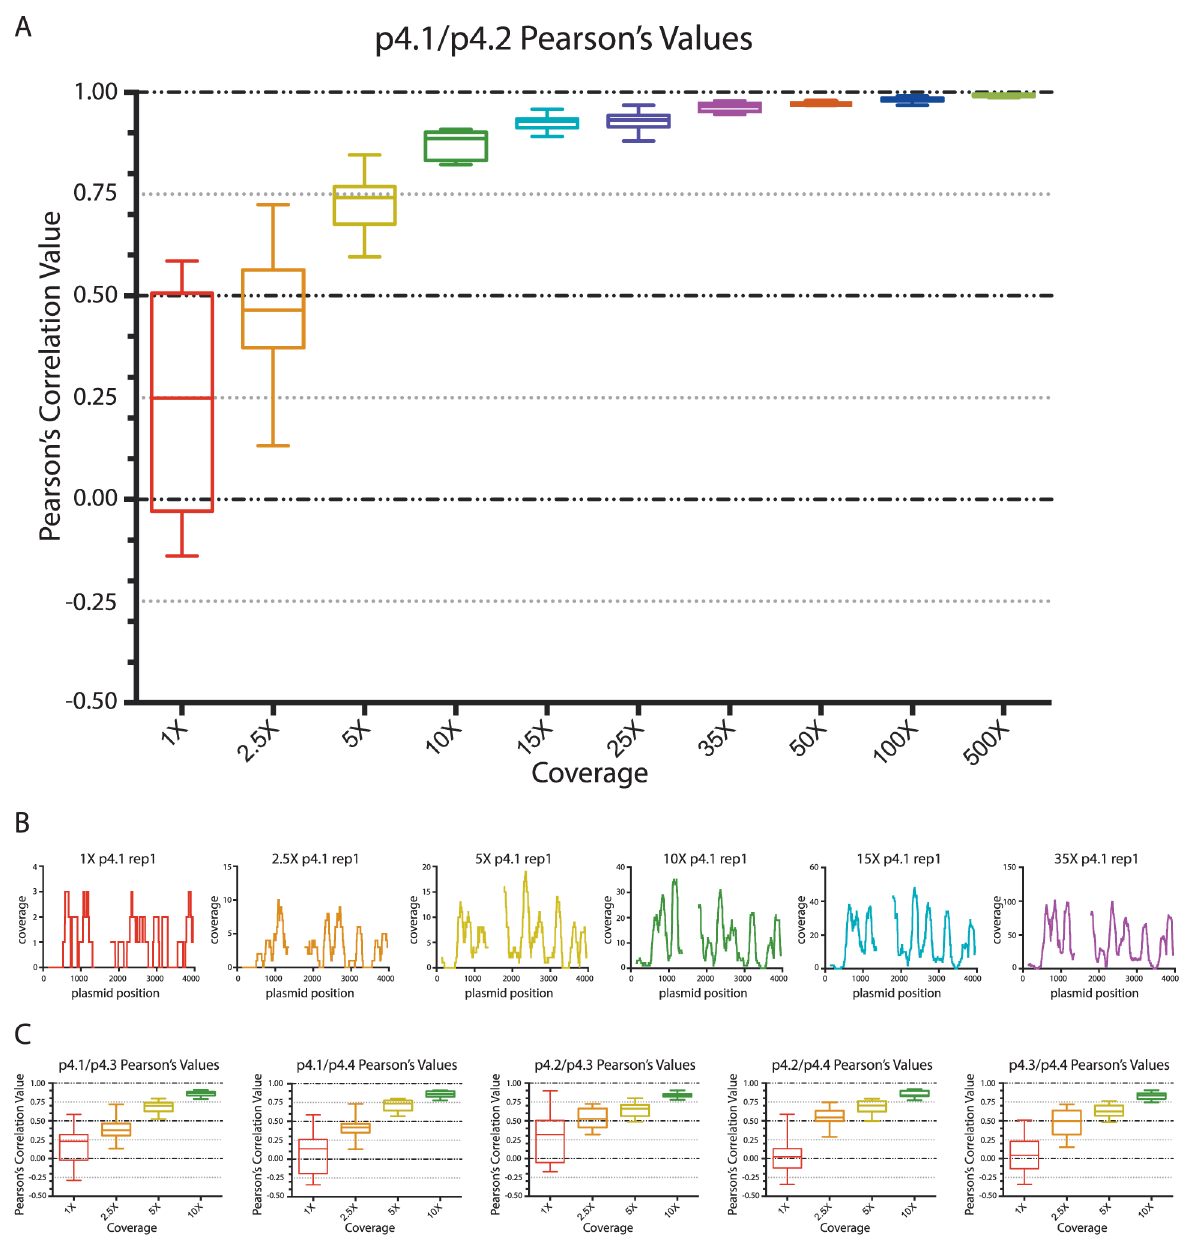
Figure 5. Comparison of correlation values show minimal acceptable coverage levels for invitrosome experiments. 5A Range of correlation values at each coverage level for the pair-wise comparisons of the three replicates for plasmid p4.1 and the three replicates for plasmid p.4.2. The Pearson’s correlation values are on the y-axis and the coverage levels are on the x-axis. The range of correlation values for each coverage level is plotted as a whisker plot composed of the 30 pair-wise comparisons at each coverage level. 5B Coverage plots for replicate 1 of plasmid p4.1 at coverage levels: 1X, 2.5X, 5X, 10X, 15X and 35X. The colors of the coverage plots correspond to the whisker-plot colors of the same coverage levels in 5A. 5C Whisker plot graphs showing the variability of correlation values at low levels of coverage (1X-10X) for all combinations of the kat-group plasmids. In 5A–5C the colors red, orange, yellow, green, indigo and purple represent data from coverage levels of 1X, 2.5X, 5X, 10X, 15X and 35X, respectively.